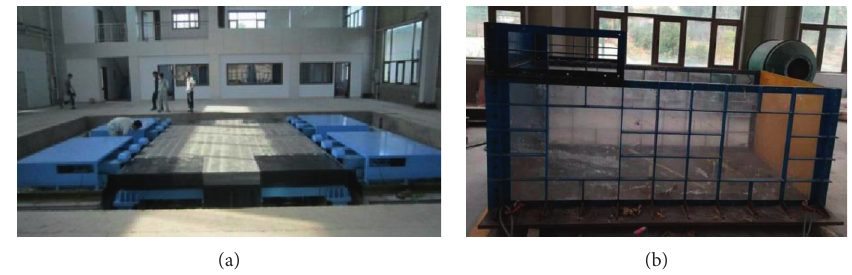
Figure 8: (a) Large-scale shaking table; (b) model box.